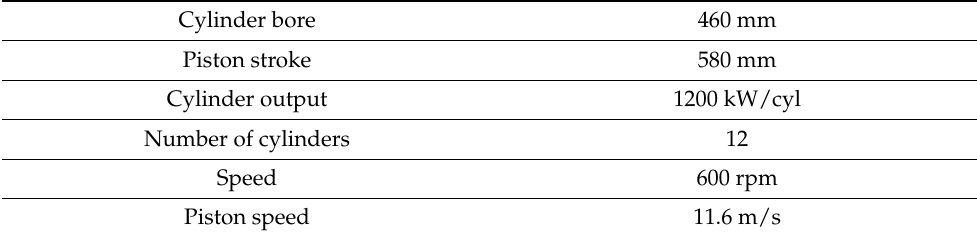
Table 1. Specifications of the medium-speed four-stroke main engine.